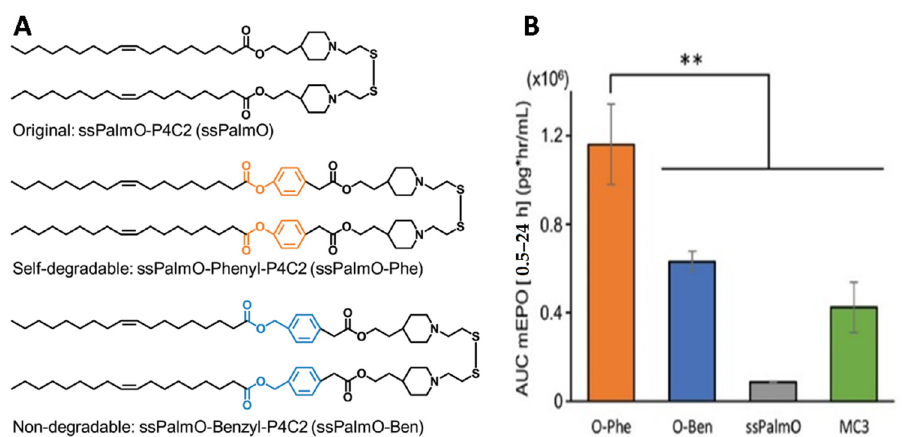
Figure 4. Improvement in mRNA expression in vivo by tuning the intracellular degradation. ( A ) Structures of the original lipid (ssPalmO), the lipid with a degradable phenyl ester (ssPalmO-Phe), and the lipid with a non-degradable benzyl ester (ssPalmO-Ben); ( B ) LNPs prepared with EPO mRNA were intravenously injected in mice (0.05 mg kg − 1 ) before determination of blood EPO concentration by ELISA 24 h after injection (** p < 0.01). Reproduced from [73] under creative common license.